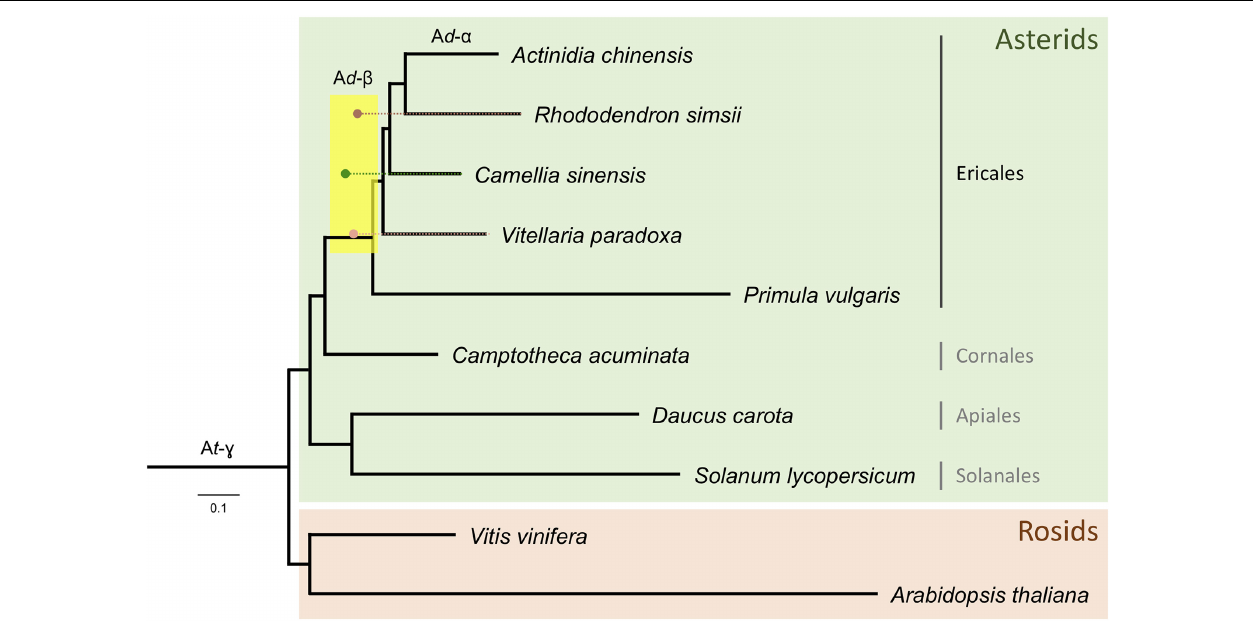
FIGURE 5 | Phylogenetic tree of the Ericales, rooted with Rosids, with branch lengths in K S units. Corrected K S ages (see text for details) of WGD events identified from anchor pairs in R. simsii , C. sinensis , and shea are indicated by brown, green, and pink dots, respectively. A likely shared WGD event in the Ericales (A d - β ) is spanned by the yellow